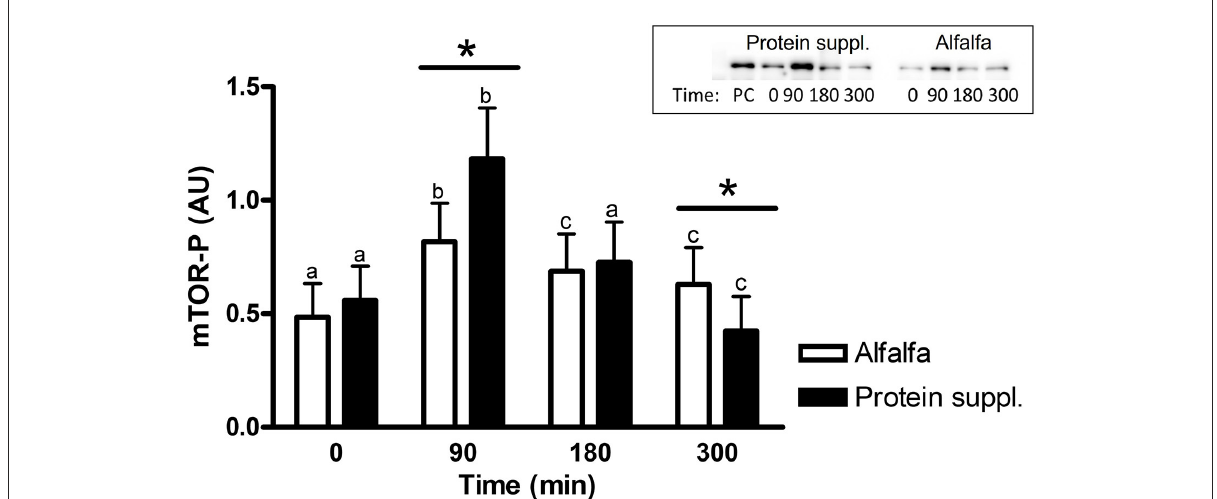
FIGURE3 Relative abundance of phosphorylated mTOR protein in gluteal muscle samples post consumption of alfalfa pellets vs. a protein supplement. Effect of treatment by time interaction on gluteal muscle abundance of phosphorylated mTOR protein at 0, 90, 180, and 300min post consumption of the protein supplement (black bars, n = 16) and alfalfa pellets (white bars, n = 14) in all horses. Results from a representative blot are shown as an inset. Each lane on the blot represents a time point from the same horse. PC: positive control. a,b,c Different letters indicate differences between timepoints within each protein source. * Indicates differences between protein sources within a timepoint. Effect of treatment by time interaction, P = 0.03. Values for abundance of phosphorylated mTOR were normalized to total protein. AU; arbitrary units. Data presented as least square means ± standard error of the mean.